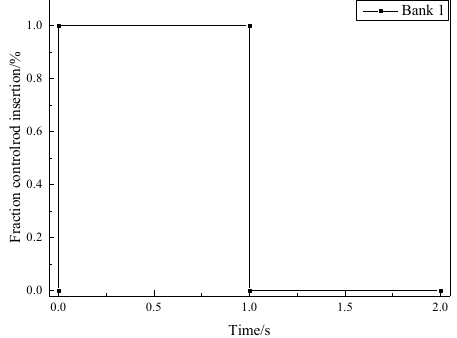
Figure 1. Control rod movement in the transient exercise